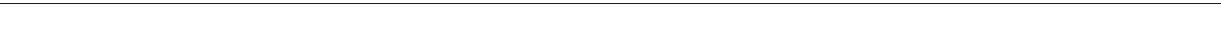
Fig. 3 Dynamic Admixture Point Process (DAPP) model: rationale and results. a The DAPP model fi ts smoothly time-varying weights ( α and (1 − α )) capturing the relative contribution of A- and B-like response distributions to each AB dual-sound trial (point1). The dynamic tendencies of the α curves were then used to generate projected new α curves for hypothetical future draws from this distribution. The waviness and central tendencies were quanti fi ed by computing the max swing size and trial-wise mean for an individual trial drawn from the distribution (point 2). Low max swing sizes indicate fl at curves and higher values indicate wavy ones (point 3, right panel). Similarly, the distribution of trial-wise means could be bimodal (Extreme) or unimodal (Central) (point 3, left panel). b – d Fit alphas for three example triplets (triplets in b – d are the same as in Fig. 2f, g, h, respectively) and the distributions of trial-wise means and max swing sizes for future draws from the alpha curve generator. e The pattern of DAPP results extended the whole- trial analysis results. Triplets categorized as Mixtures with a win probability > 0.95 tended to be tagged as Flat-Extreme (as example in b ). Triplets categorized as Intermediates fell in two different main groups, Wavy-Central (as example in c ) and Flat-Central (as example in d ). Information about the Skewed vs. Symmetric tag is not shown. See Supplementary Table 1 and Supplementary Figures 6 and 7 for a complete listing of all the tag combinations and additional